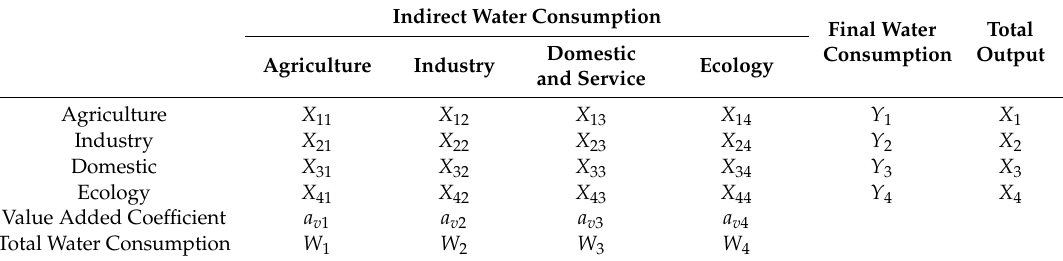
Table A3. Structure of water consumption input and output